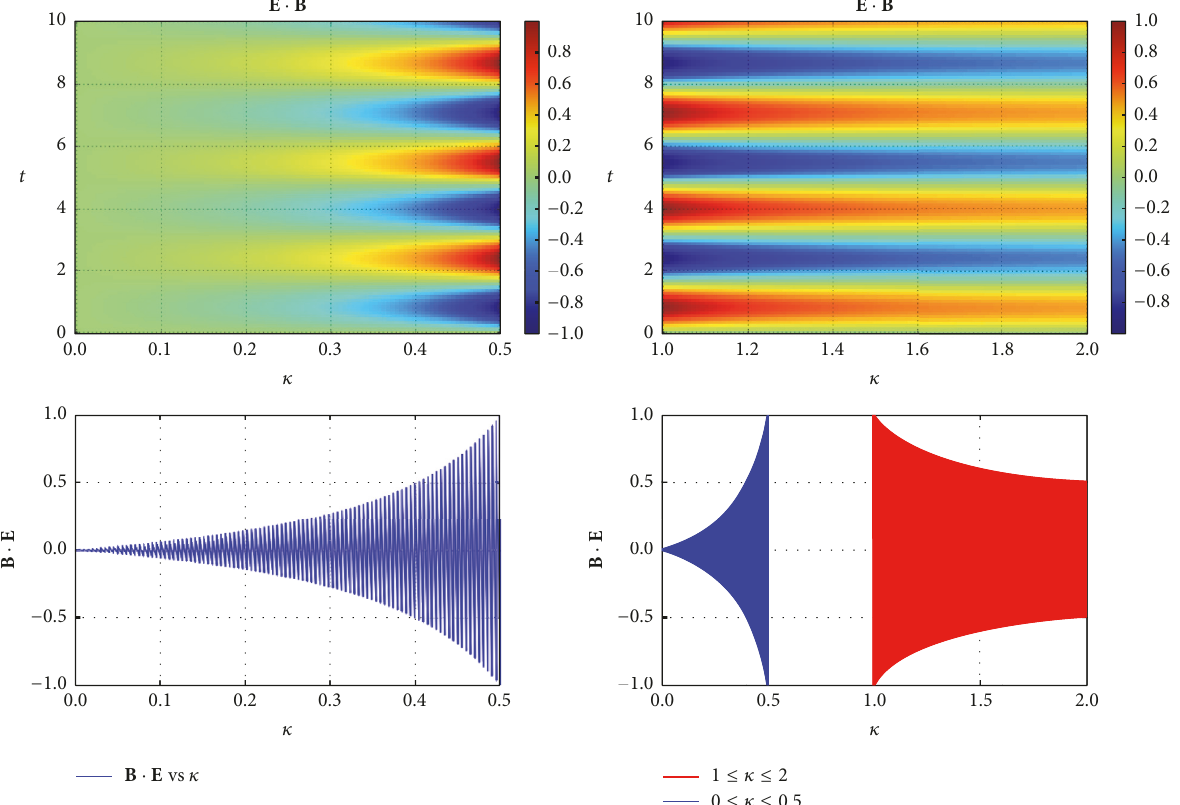
Figure 3: (Color online) scalar product of the circularly polarized electric field with the magnetic fields with dependence on 𝜅 , considering 0 ≤ 𝜅 ≤ 1/2 and 1 ≤ 𝜅 ≤ 2 .